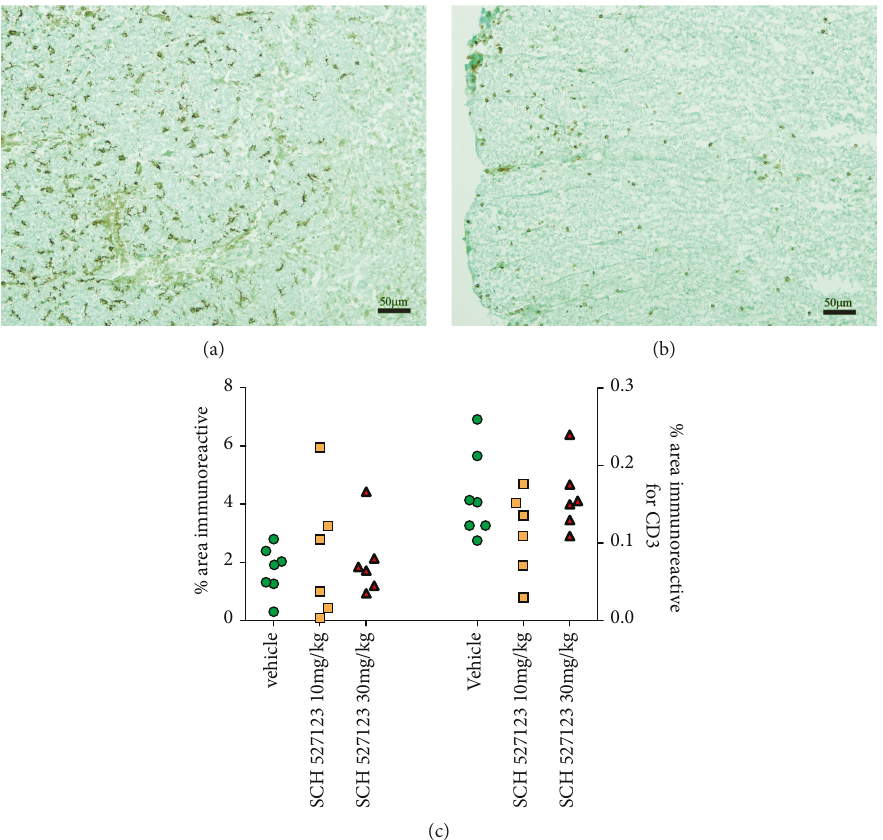
Figure 4: CXCR2 antagonist, SCH527123, does not alter macrophage/microglial activation or CD3 T cell in fl ux into the spinal cord. Representative sections of immunohistochemistry using IBA1 to mark macrophages and microglia are shown (a) and CD3 to mark T cells (b) ( bar = 50 μ m ). Focusing only on animals in cohort 2 for which Hu-IgG signal and astrocyte damage were high, neither IBA1 (left axis) nor CD3 (right axis) signal was altered by SCH527123 treatment (blue squares, 10mg/kg; red triangles, 30mg/kg) as compared to vehicle- treated animals (green